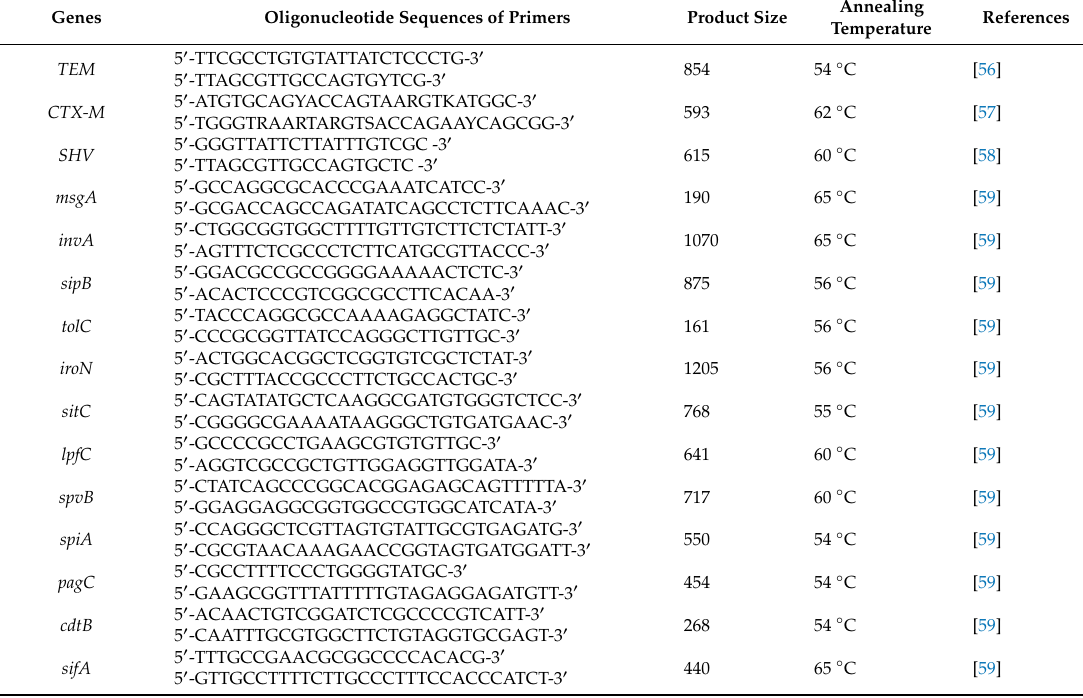
Table 4. Primer’s oligonucleotide